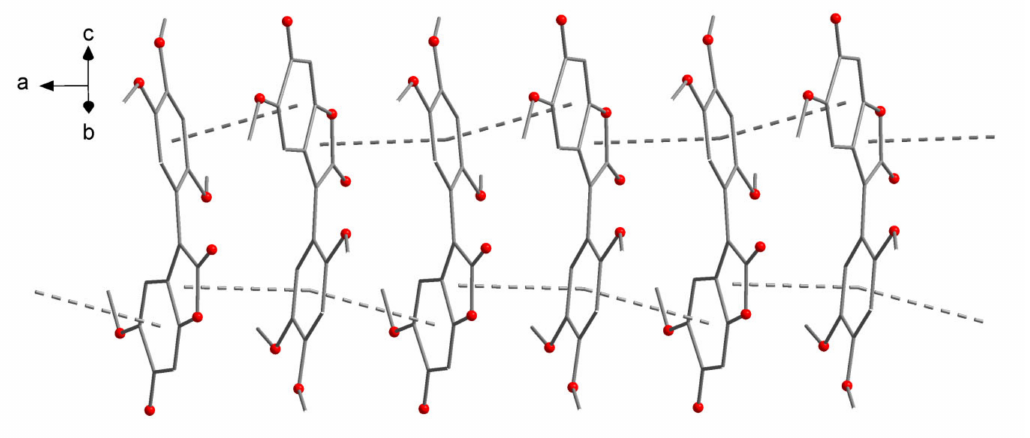
Figure 5. Intermolecular π interactions in compound 6 , resulting in a one-dimensional supramolecular structure extending along the crystallographic a